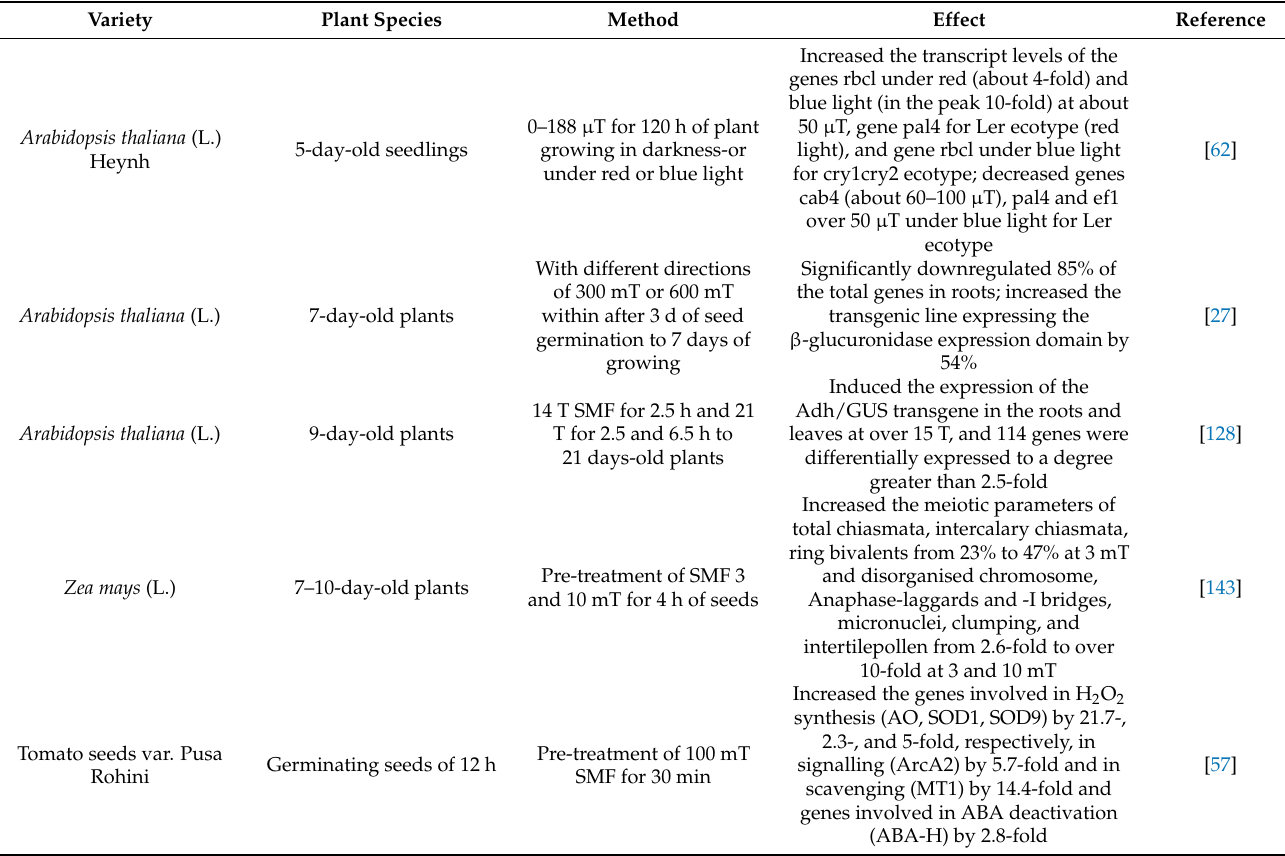
Table 5. Effects of MFs on gene